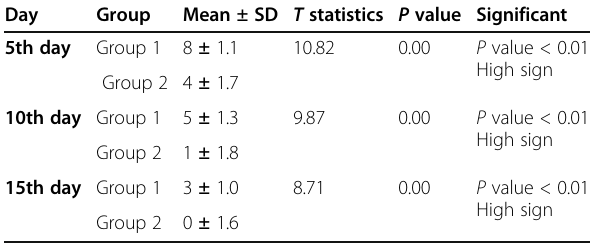
Table 5 Dysphagia grading post-operatively